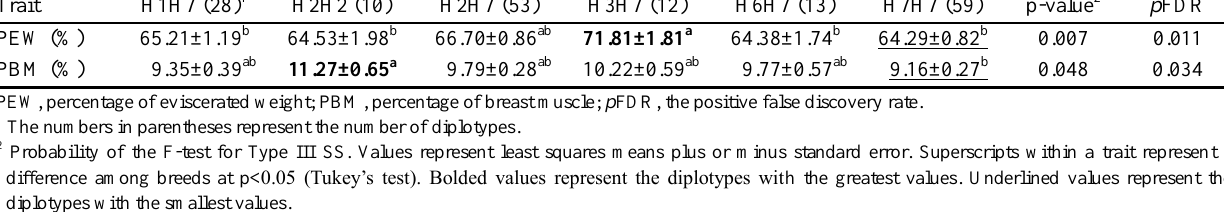
Table 6. Diplotype effects on PEW and PBM in chickens Trait